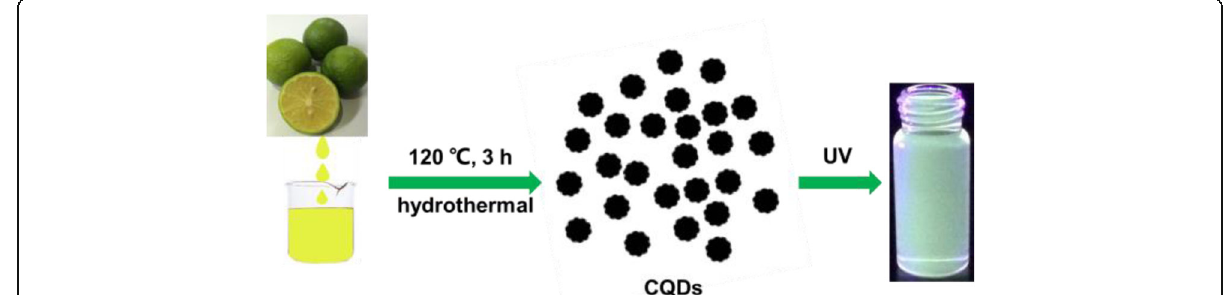
Fig. 1 Preparation of CQDs from lemon juice by hydrothermal treatment